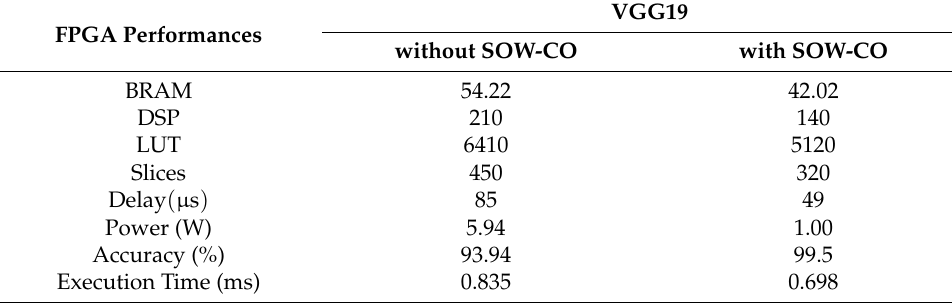
Table 10. Analysis of FPGA performances for VGG19.